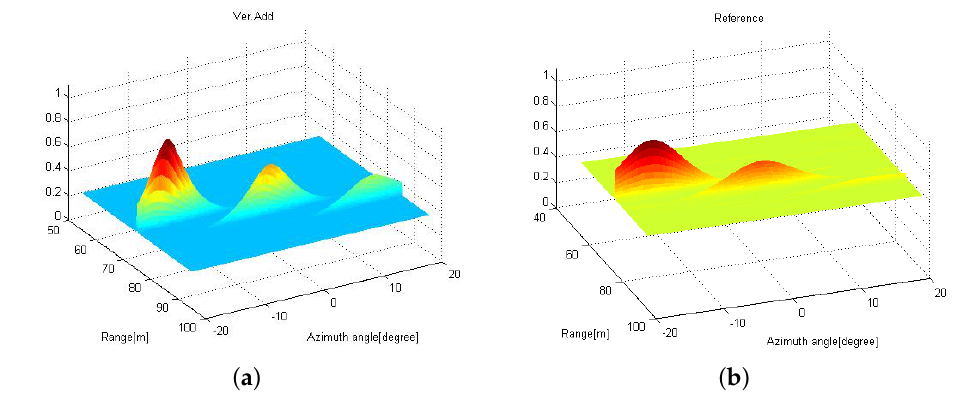
Figure 5. Radar images obtained by using ( a ) the conventional 2D MUSIC and ( b ) the proposed distributed 2D MUSIC in a top view.